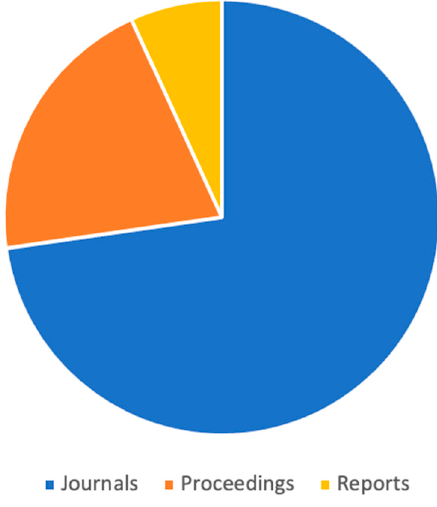
Figure 3. Type of articles discussed.